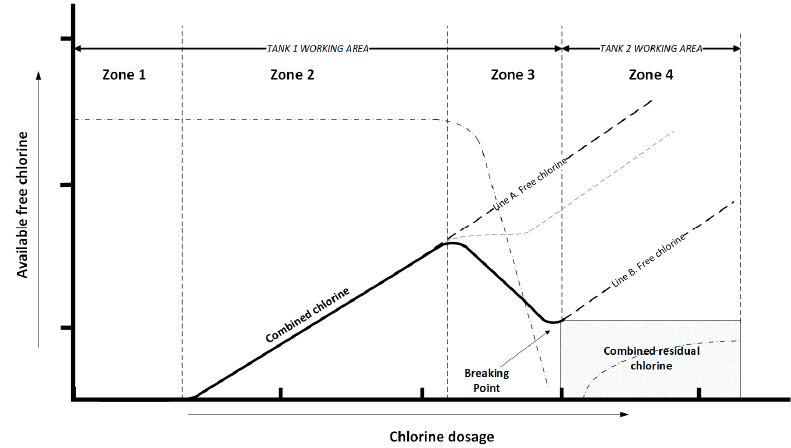
Figure 4. Transition in the dosing areas of the chlorination in tank 1 and inlet of tank 2.